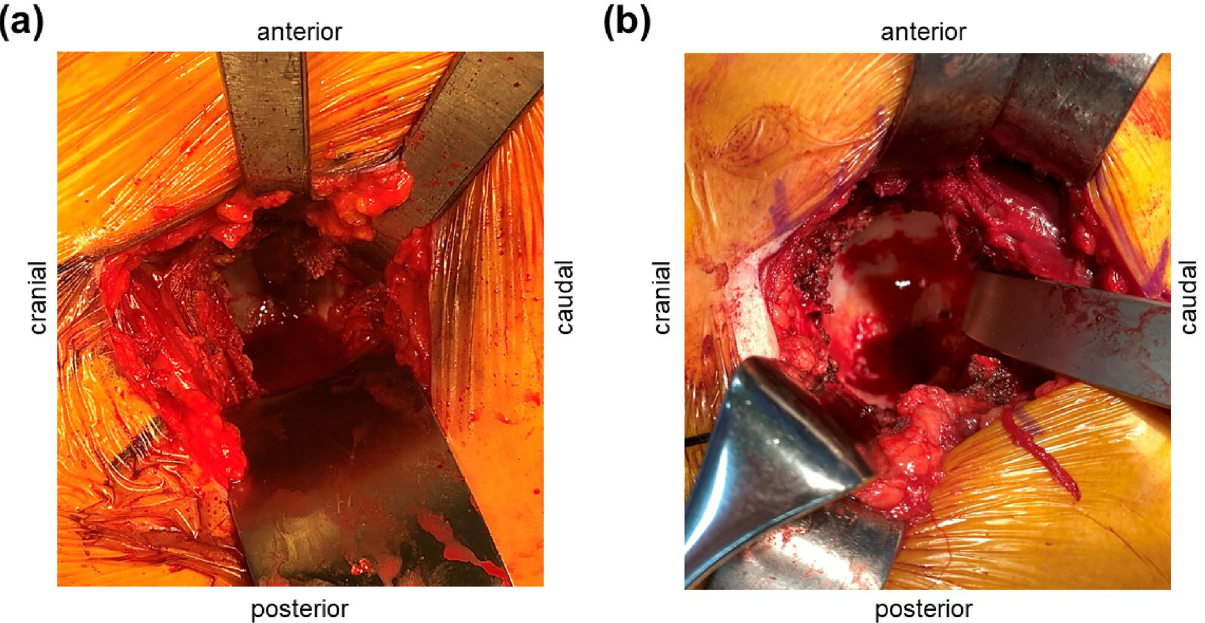
Figure 4. Photographs of the acetabular visual field during registration. (a) Mini-anterolateral approach, (b) posterior